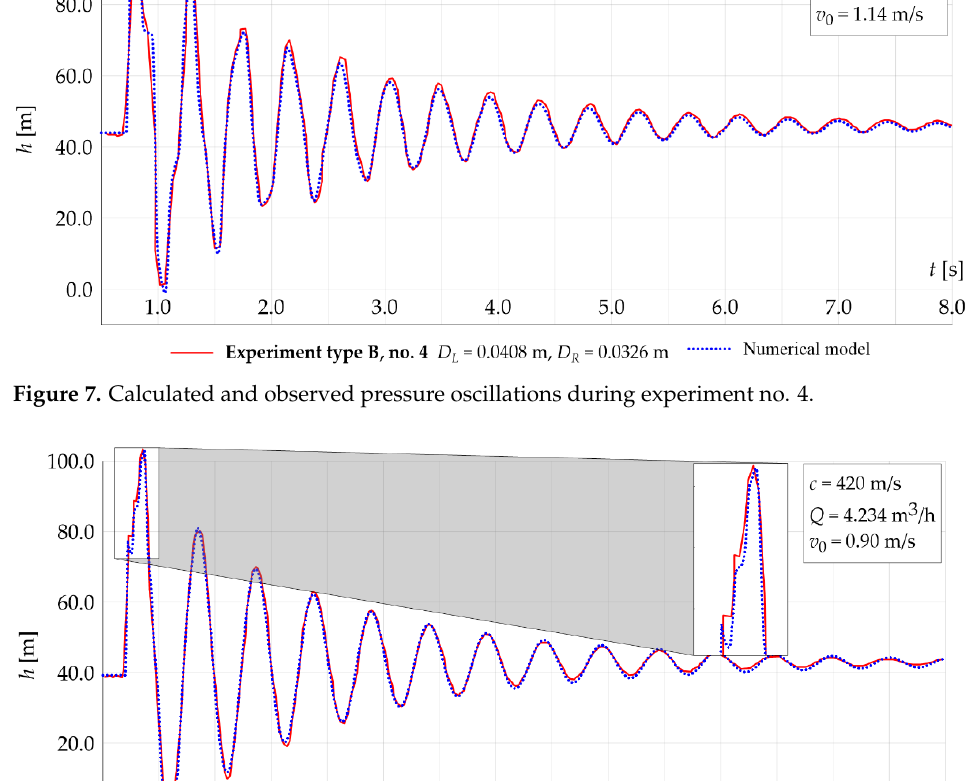
Figure 6. Calculated and observed pressure oscillations during experiment no. 3.